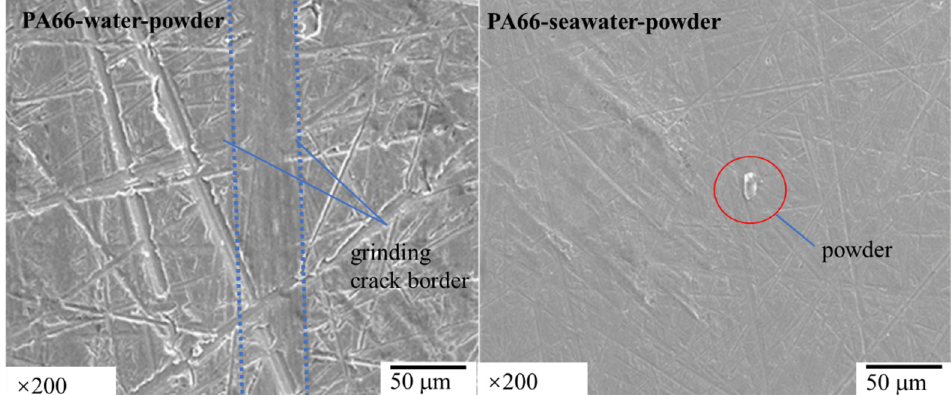
Table 7. Element analysis of wear marks on the aluminum plate against PA66 pins. Pin-Solution